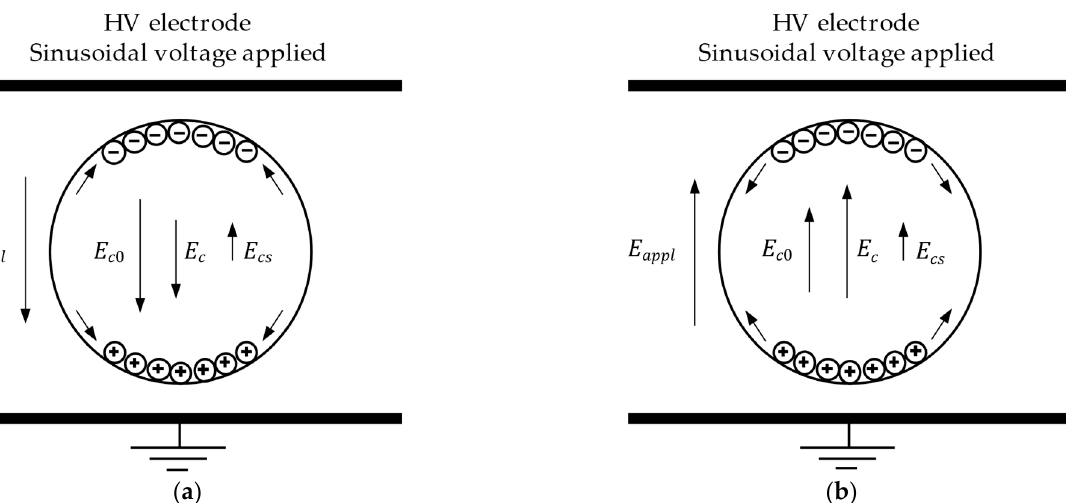
Figure 2. Movement of free charges along the cavity surface: ( a ) when E c ( t ) and E cs ( t ) have opposite directions, and; ( b ) when E c ( t ) and E cs ( t ) have the same